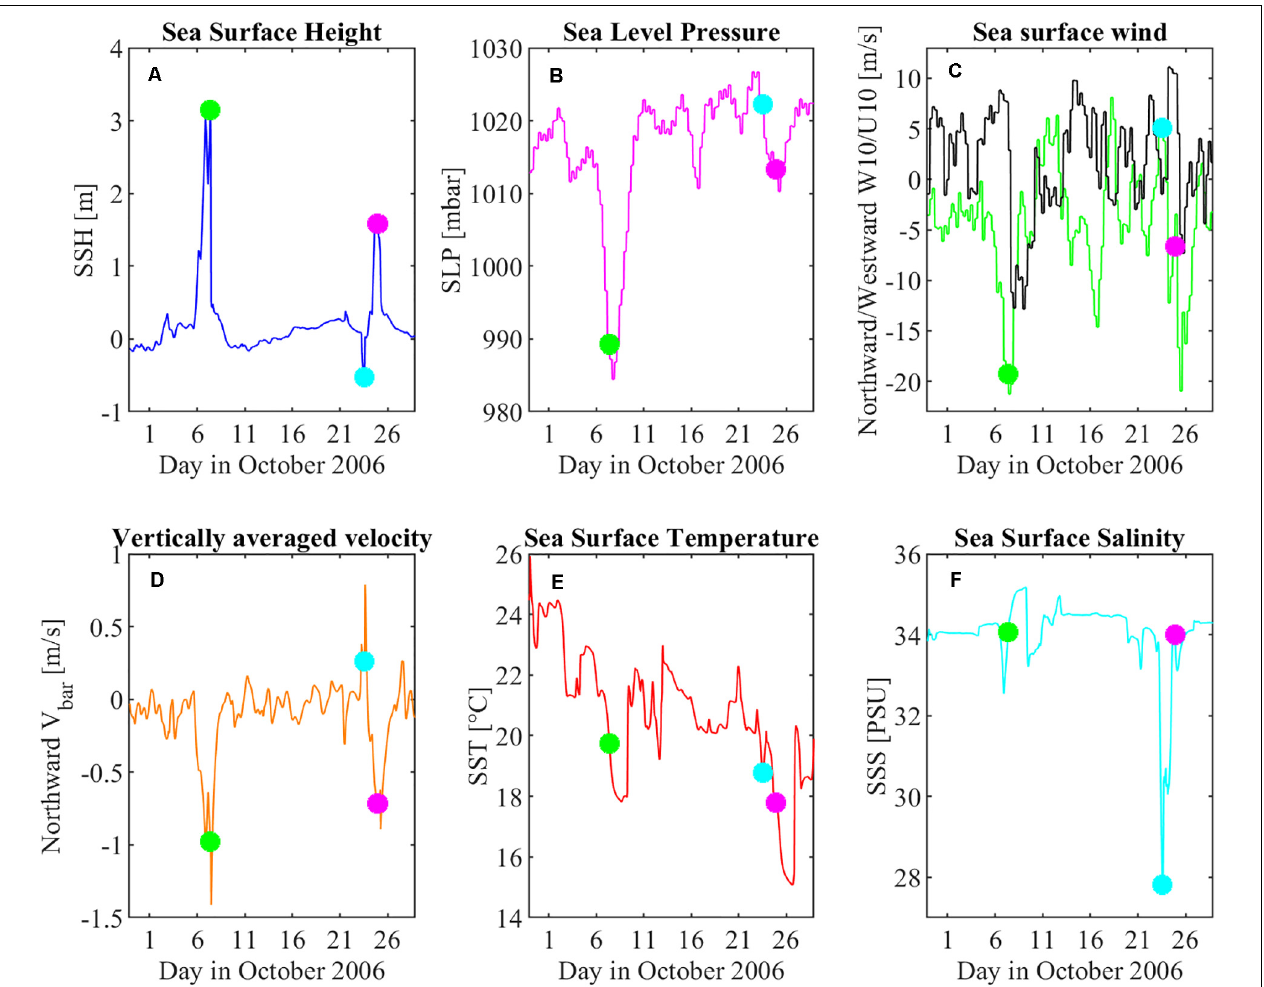
FIGURE 11 | COAWST modeled results of (A) Sea Surface Height, (B) Sea Level Pressure, (C) Sea surface wind (green: North–South direction; black: West–East direction), (D) Vertically averaged velocity (North–South direction), (E) Sea Surface Temperature, and (F) Sea Surface Salinity in Hasaki (green dot: October 7 at 9 am; cyan dot: October 23 at 1 pm; magenta dot: October 24 at 9